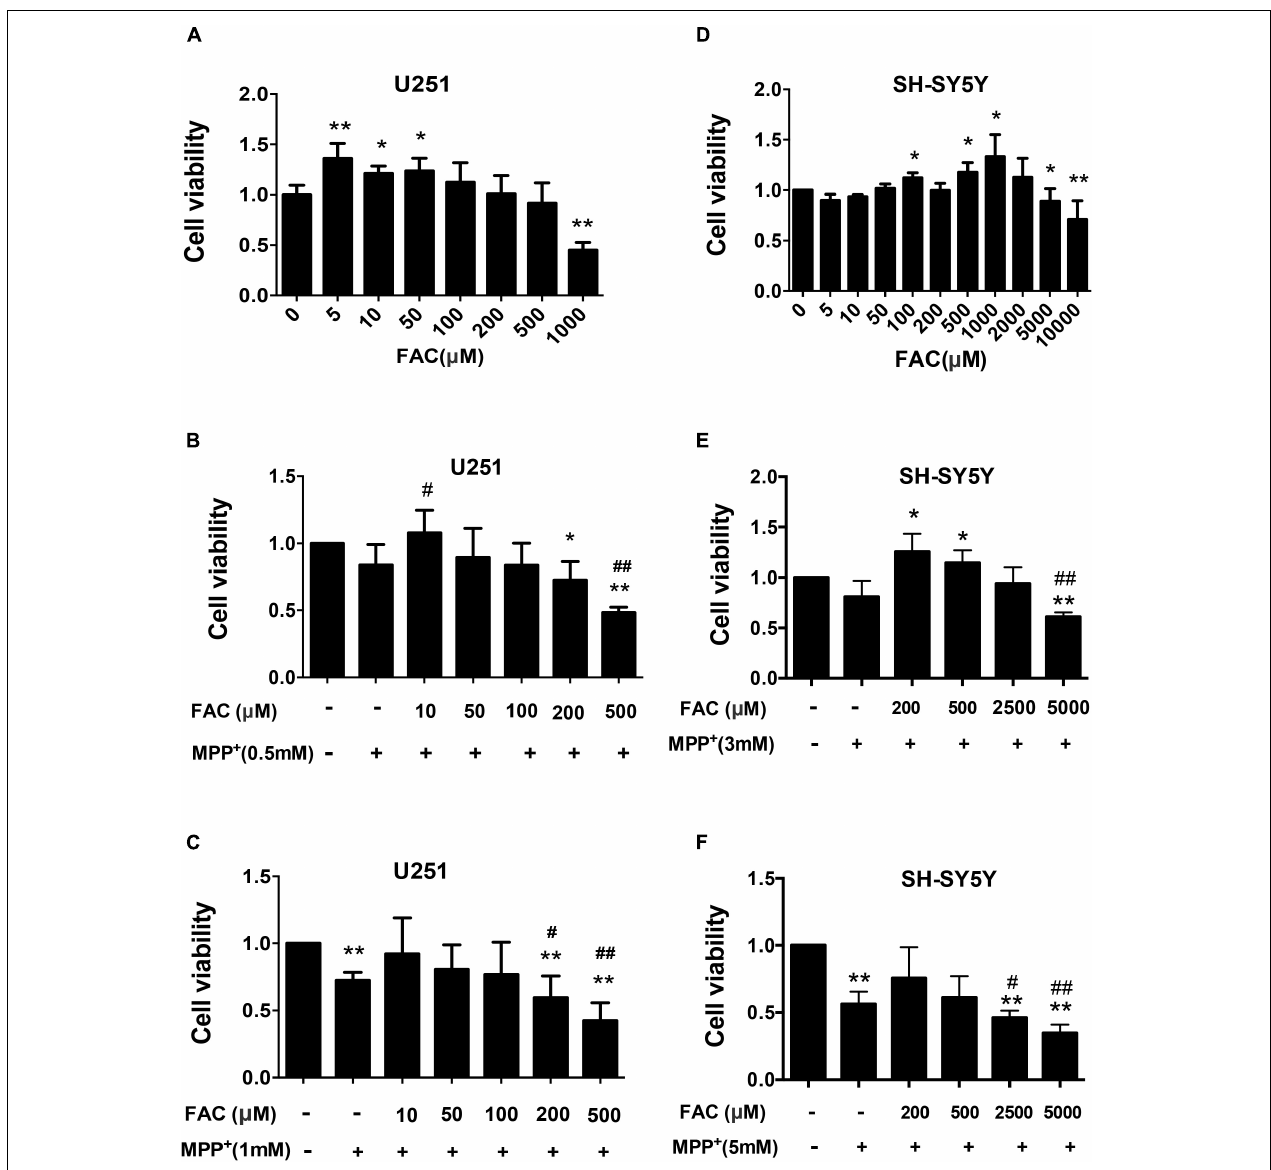
FIGURE 8 | The influence of Ferric ammonium citrate on the cell viability of cultured U251 and SH-SY5Y cells in the presence of MPP + . (A–C) Cell viability was determined for U251 in the absence (A) and in the presence of low (B) and high (C) levels of MPP + . (D–F) Cell viability was determined for SH-SY5Y cells in the absence (D) and in the presence of low (E) and high (F) levels of MPP + . Note that in the absence of MPP + , low levels of ferric ammonium citrate (FAC) enhanced the viability of both cell types, while high levels decreased it (A,D) . In the presence of MPP + , lower-level FAC either enhanced (when MPP + at lower levels, B ) or restored (when MPP + high levels, C ) viability of U251 cells. However, high levels of FAC led to a reduction of cell viability when compared to controls or to either level of MPP + exposure (B,C) . Similar to U251 cells, the viability of SH-SY5Y cells in the presence of low levels of MPP + could be enhanced with lower levels of FAC